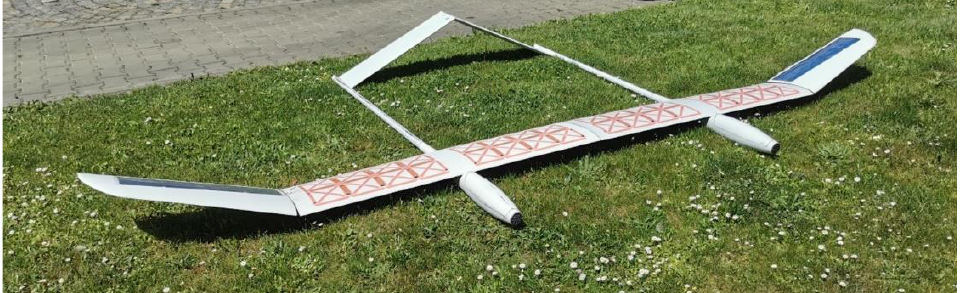
Figure 1. The first prototype of TwinStratos.